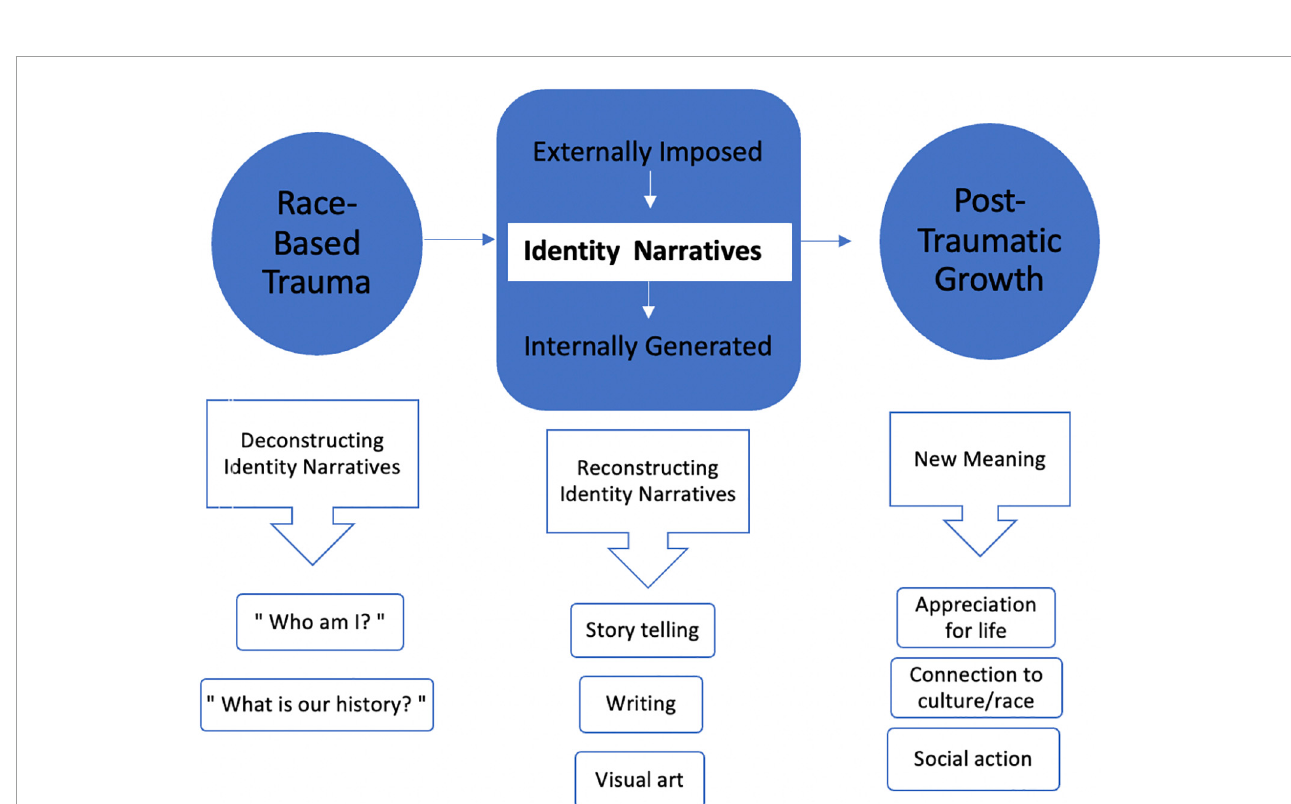
FIGURE2 Framework for post-traumatic growth following race-based